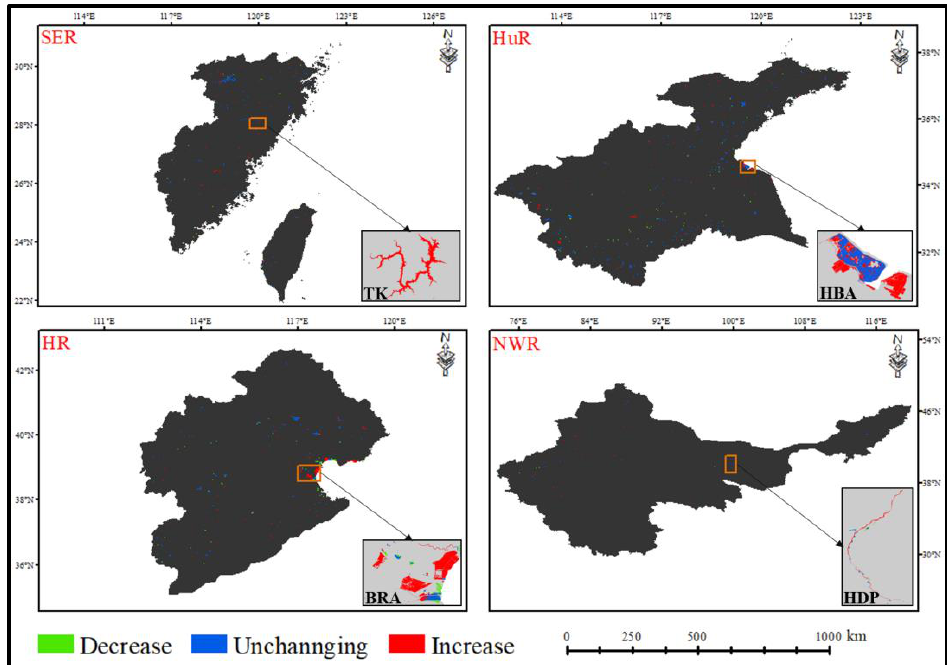
Figure 10. Changes in the spatial distribution of artificial water bodies in 2020 compared with 2000 in SER, HuR, HR and NWR.